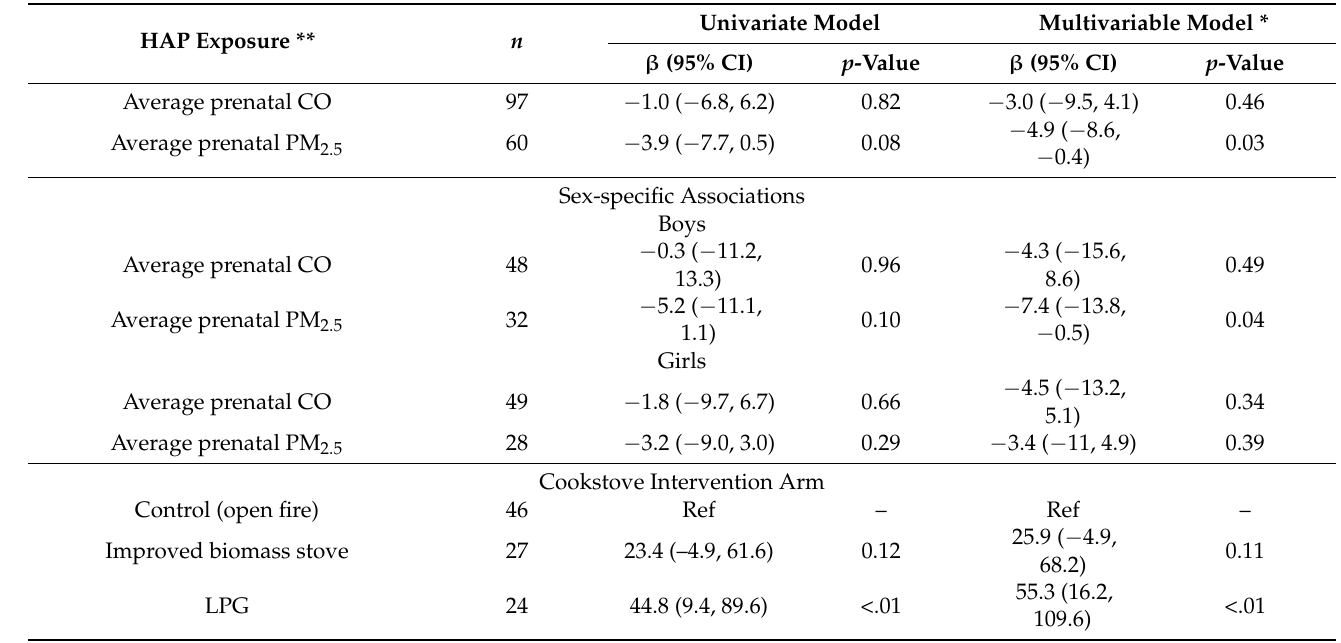
Table 2. Percentage change in cord blood leukocyte telomere length per unit increase in household air pollution (HAP) exposure or cookstove intervention arm as compared with control: linear